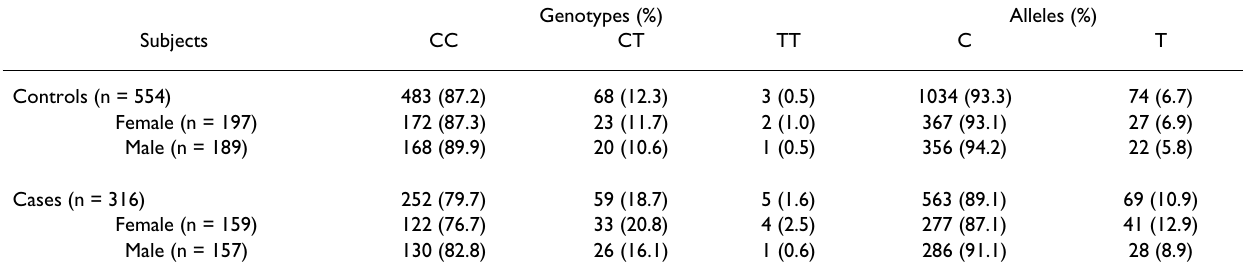
Table 1: Analysis of the PTPN22 C1858T variant in the Spanish cohort Genotypes (%) Alleles